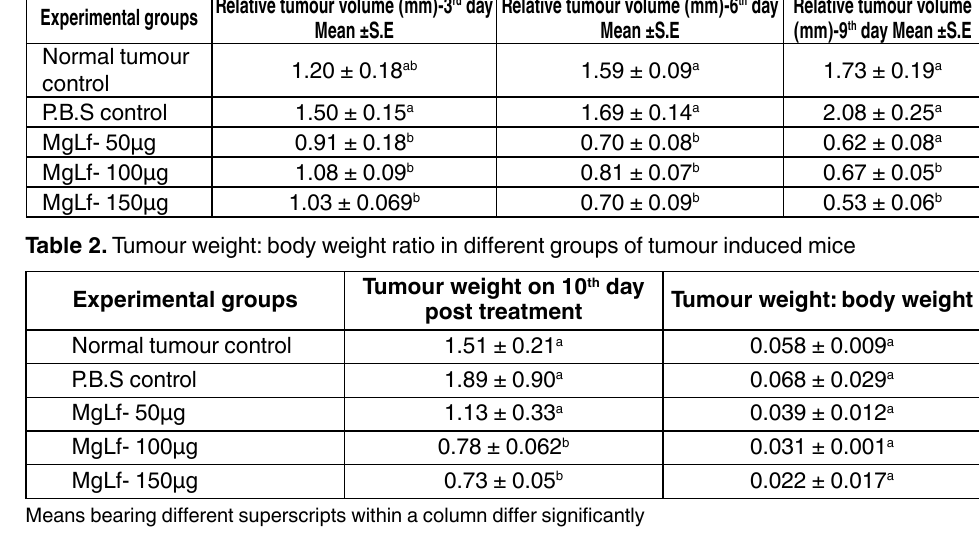
Table 1. Relative tumour volume of different groups of tumour induced mice Relative tumour volume (mm)-3 rd day Experimental groups Mean ±S.e